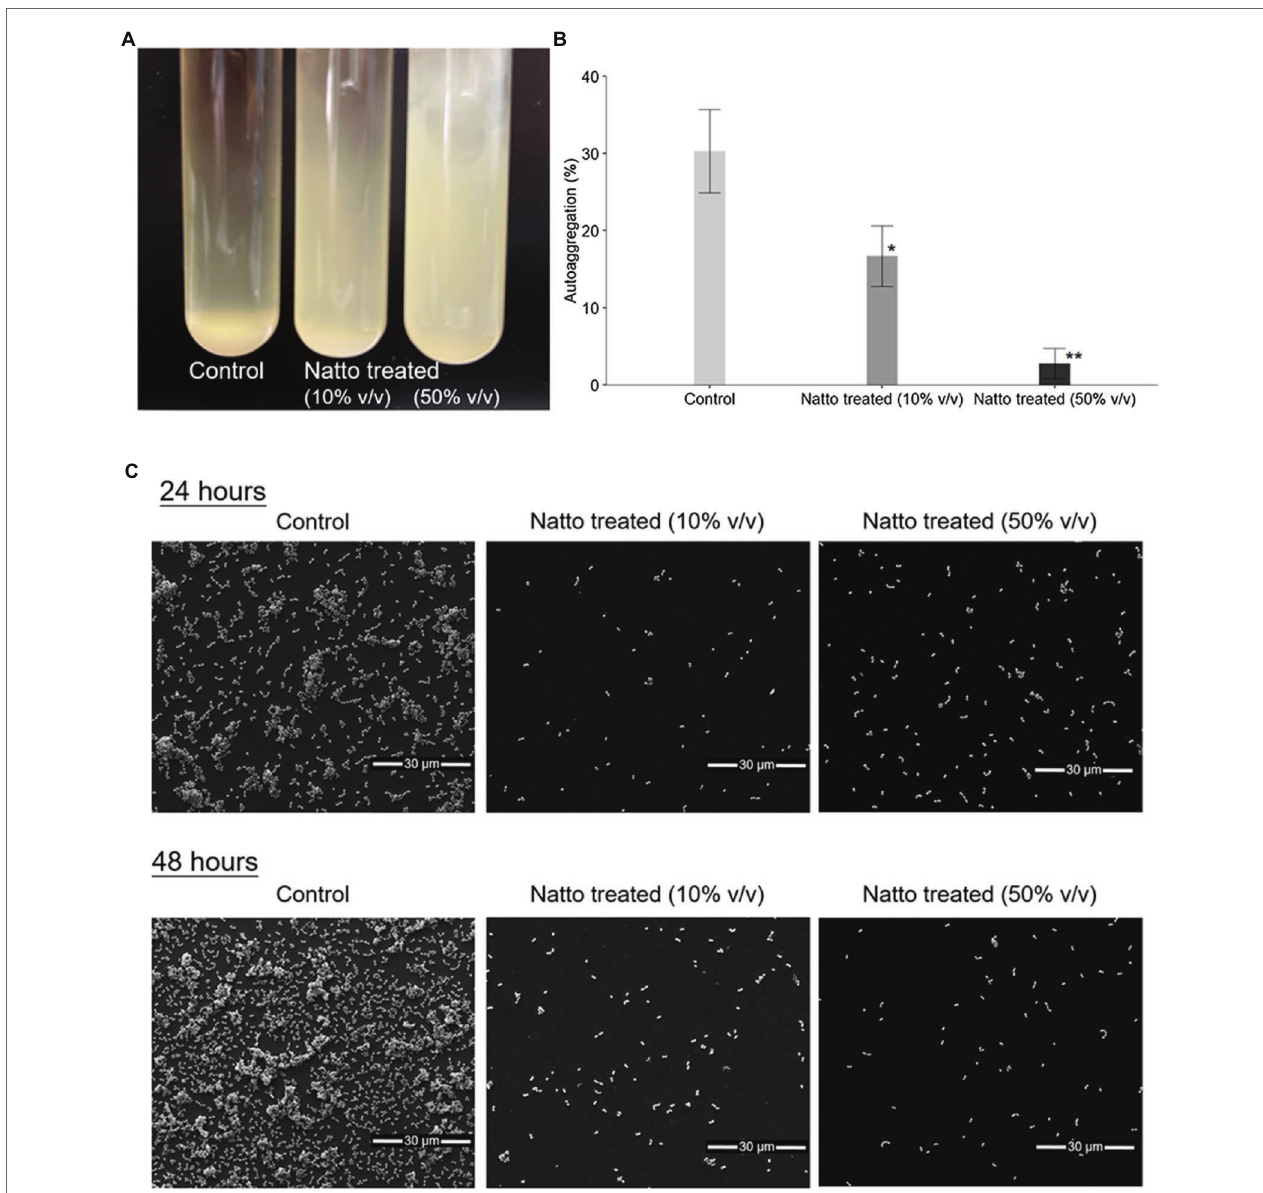
FIGURE 2 | Bacillus subtilis natto supernatant inhibits E. faecalis autoaggregation. (A) Macroscopic analysis of untreated (control) and B. subtilis natto supernatant- treated (10 and 50% v/v) E. faecalis cultures after 24 h of cultivation. (B) Percentage autoaggregation exhibited by untreated (control) and B. subtilis natto supernatant-treated (10 and 50% v/v) E. faecalis . The data are presented as the means ± SDs ( n = 3). Values with asterisks (*) were significantly different compared with the negative control (untreated) group according to Duncan’s multiple range tests (* p < 0.05; ** p < 0.01). (C) SEM images of E. faecalis